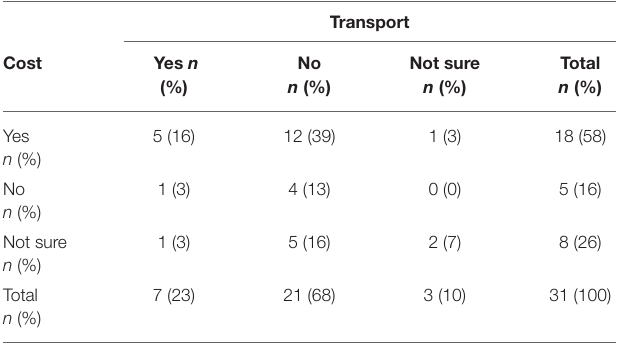
TABLE 5 | Cross-tabulation showing overlap between transportation and cost barriers to veterinary care.